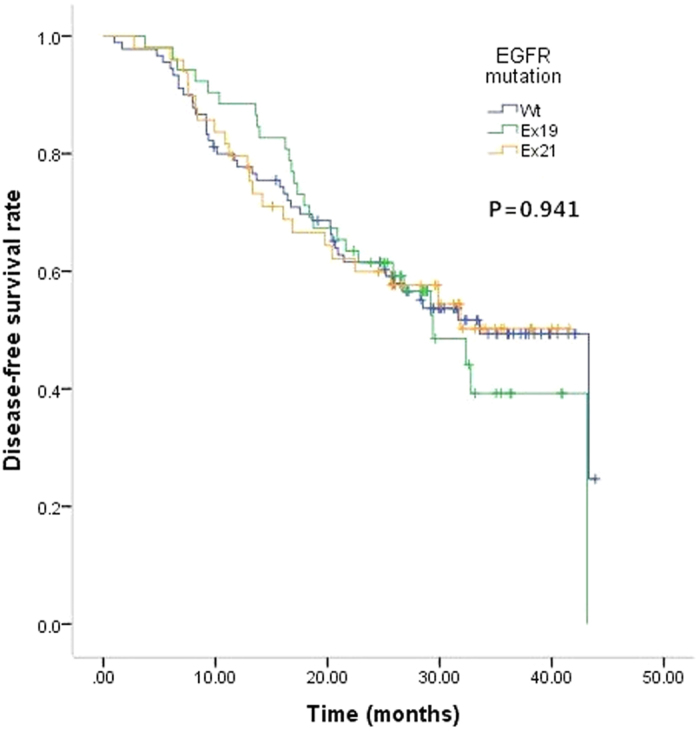
Kaplan-Meier estimates of disease-free survival (DFS) according to EGFR status (Wt, Ex19, and Ex21).The median DFS were 33.6, 29.4, and 25.7 months for patients with Wt, Ex19, and Ex21 lesions, respectively. P = 0.941.